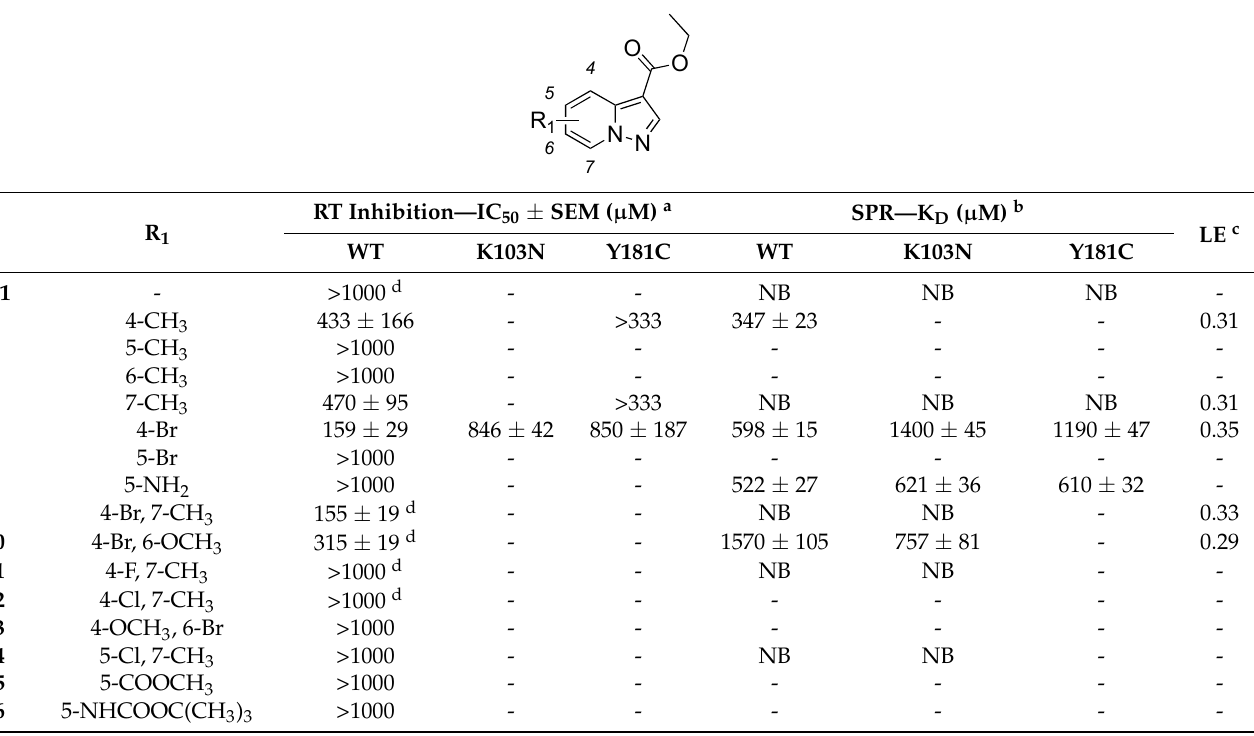
Table 1. HIV-1 RT inhibition, dissociation constants and ligand efficiencies of substituted ethyl 3-carboxypyrazolopyridine analogues (Series 1).